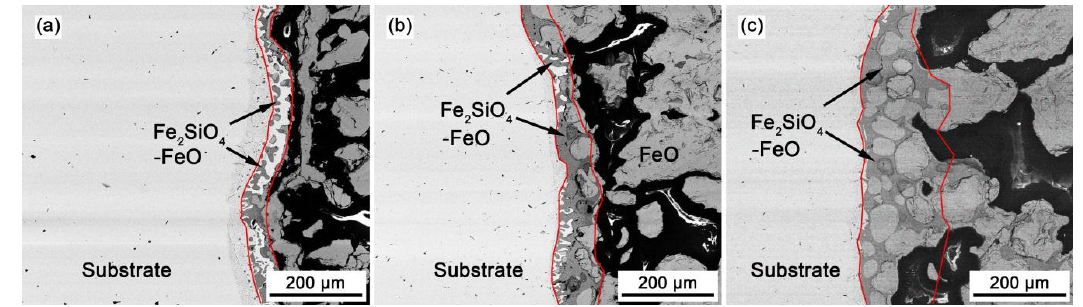
Figure 5. The typical morphology of Fe 2 SiO 4 –FeO for Routes 4–6: ( a ) Route 4, 1260 °C for 10 min; ( b ) Route 5, 1260 °C for 40 min; ( c ) Route 6, 1260 °C for 90 min. The total mass gain recorded in the oxidation experiments represents the oxidation degree.